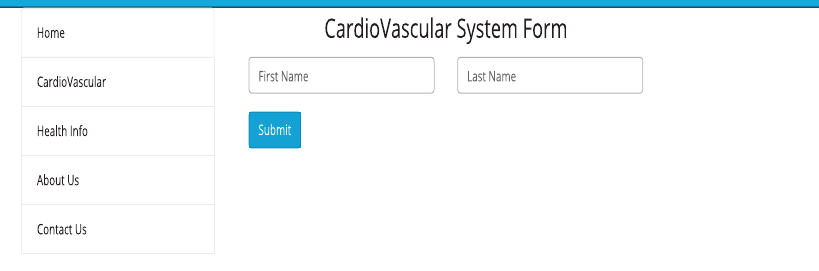
Figure 7: Receptionist